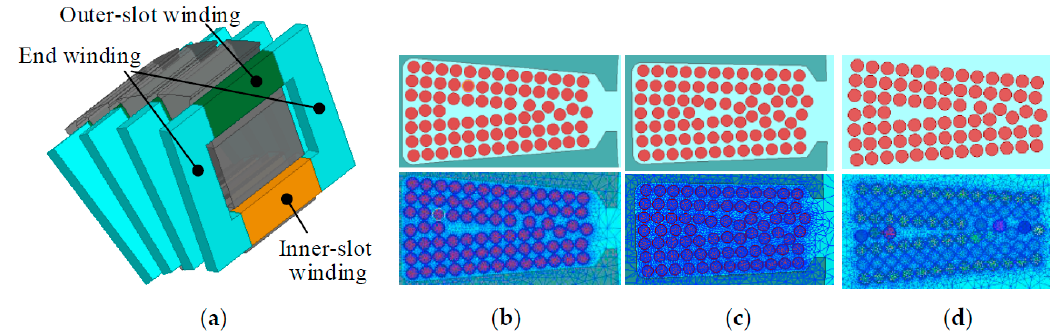
Figure 8. ( a ) Coil segments for toroidal windings; FEA models and meshes the conductors of, ( b ) inner-slot winding; ( c ) outer-slot winding; ( d ) end winding. Table 4. Copper loss with different materials of outer stator.